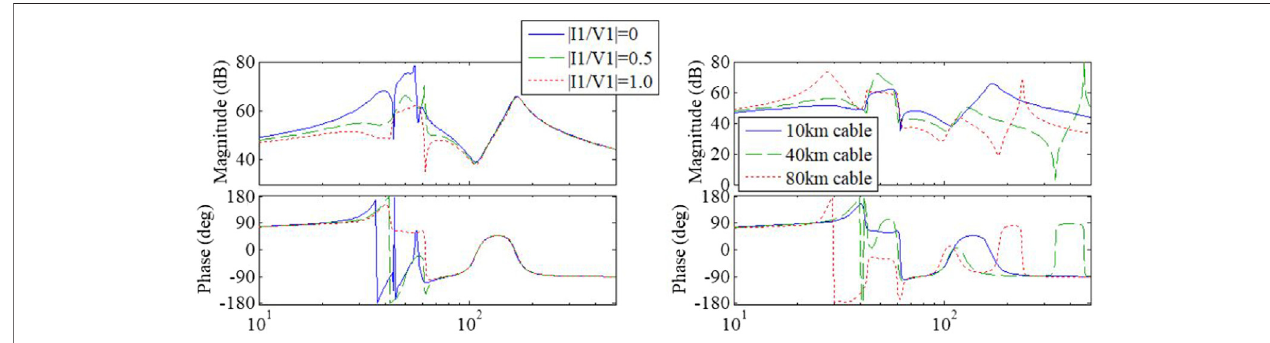
FIGURE 7 | Zw(s) under different per unit active power (left, with 10 km cable) and length of cable (right, with full-rated power output). X -axis in Hz.